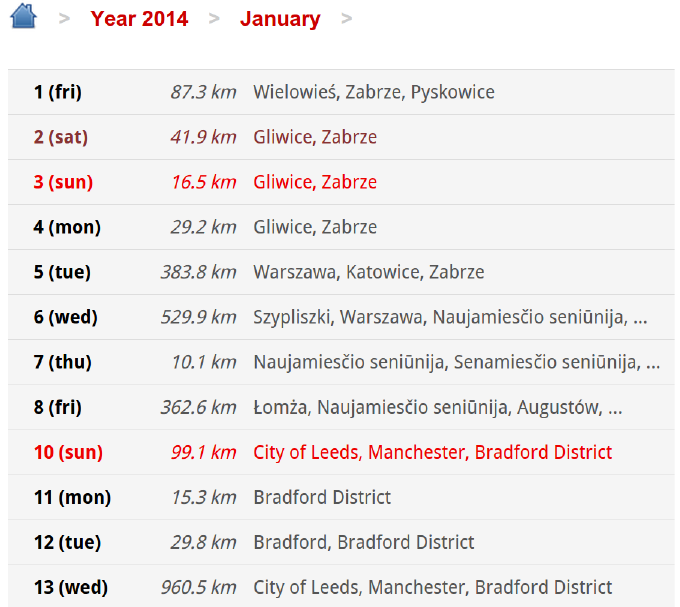
Figure 5. Exemplary screenshot of the web service. The image was cropped for